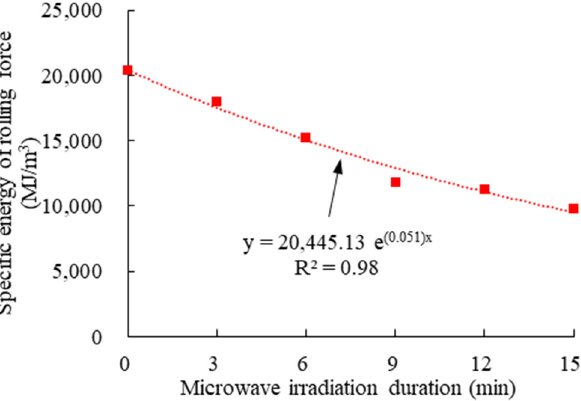
Figure 16. Relationship between the specific energy of the rolling force and the microwave exposure time .